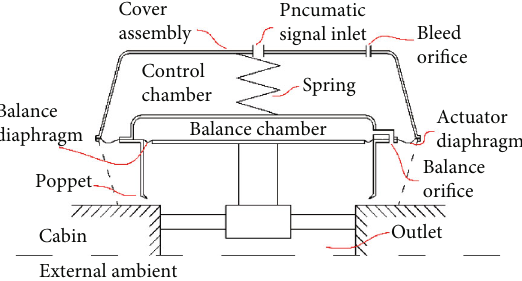
Figure 3: Schematic diagram of the out fl ow